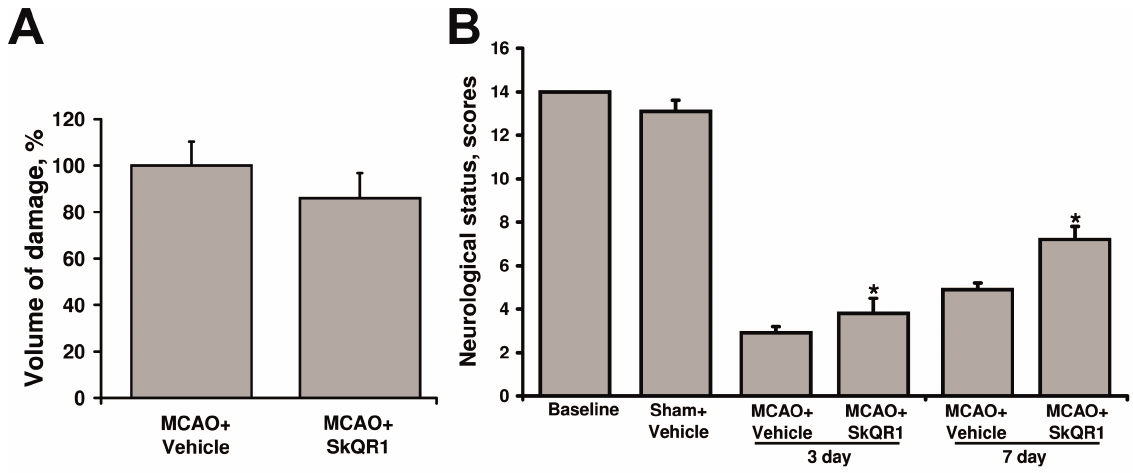
Figure 4. Neuroprotective effect of long-term treatment by SkQR1. SkQR1 at dose 0.1 μ mol/kg was administrated i/p immediately after reperfusion and for a consecutive four days. ( A ) Infarct volume was measured in the MR T2-weighted images obtained seven days